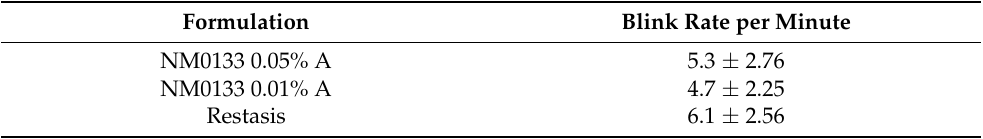
Table 9. Blink Rate Immediately Following the Topical Ocular Administration of Cyclosporine A